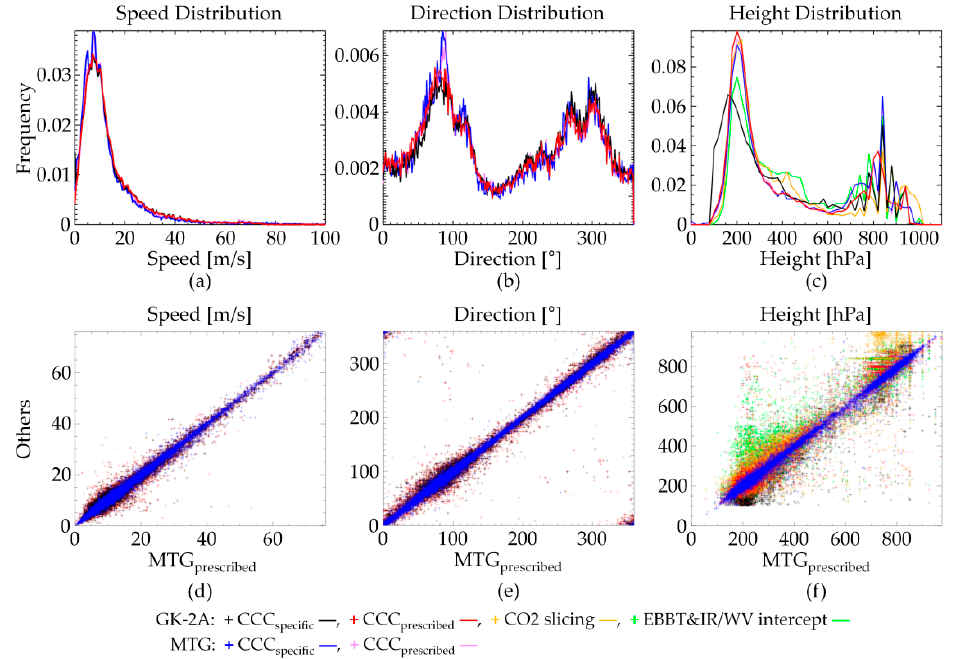
Figure 7. Distribution comparison of ( a ) speed, ( b ) direction, and ( c ) height of GK-2A and MTG AMVs for 12:10 UTC on 21 July 2016. ( a ), ( b ) GK-2A AMVs with heights from CCC in the specific configuration ( black ) and in the prescribed configuration ( red ) as well as MTG AMVs with heights from CCC in the specific configuration ( blue ) and in the prescribed configuration ( violet ). The GK-2A AMVs with heights obtained from the CO 2 slicing ( orange ) and the combined use of EBBT and IR / WV intercept methods ( green ) are additionally shown in ( c ). ( d – f ) the corresponding scatter plots are shown for the collocated AMVs for others versus MTG AMVs with heights from CCC in the prescribed configuration. The colors are the same as those in ( a – c ). The results for 05:40 UTC on 21 July 2016 were very similar. Table 5. Validation scores of GK-2A and MTG AMVs compared with GDAPS, rawinsonde in the specific configuration, and ECMWF and rawinsonde in the prescribed configuration for both 05:40 and 12:10 UTC on 21 July 2016. AMVs with CQIF > 80 were collected. GK-2A